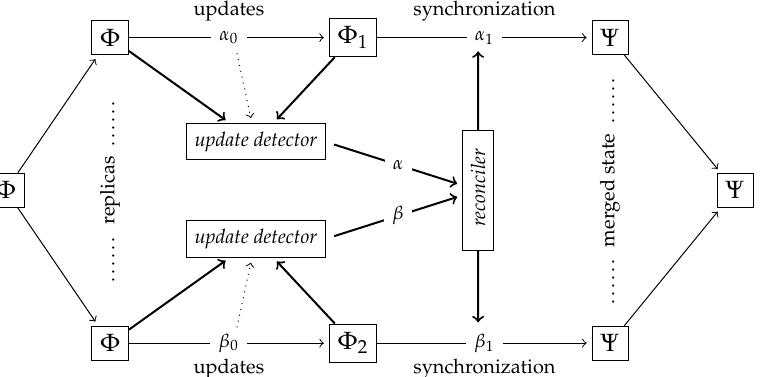
Figure 1. Outline of the synchronization process. Identical replicas of the original filesystem Φ are updated (modified) yielding the divergent replicas Φ 1 and Φ 2 . The reconciler uses the update information α and β extracted by the update detector s, and generates the synchronizing instructions α 1 and β 1 . These create the identical merged state Ψ when applied to the replicas. The update detectors determine the update information α and β either by comparing the different states of the replicas (e.g., Φ 1 vs. Φ ), or by having access to the update instructions α 0 and β 0 that were applied to Φ